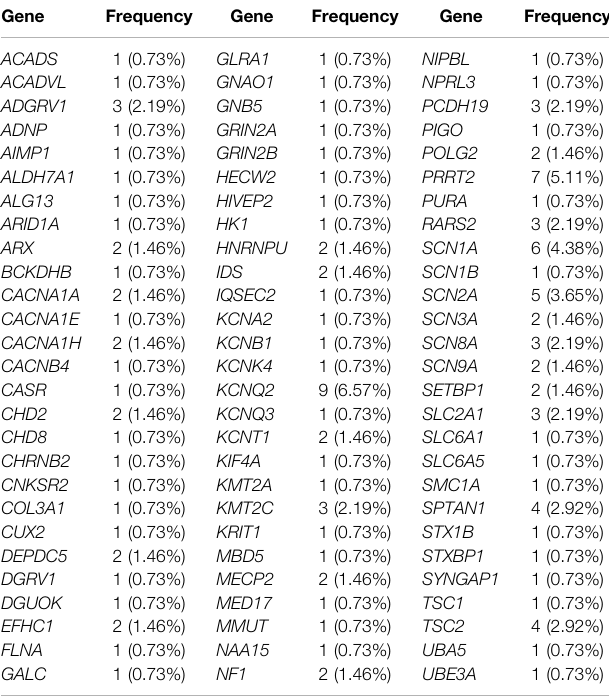
TABLE2 | The epilepsy related genes and frequency detected in this